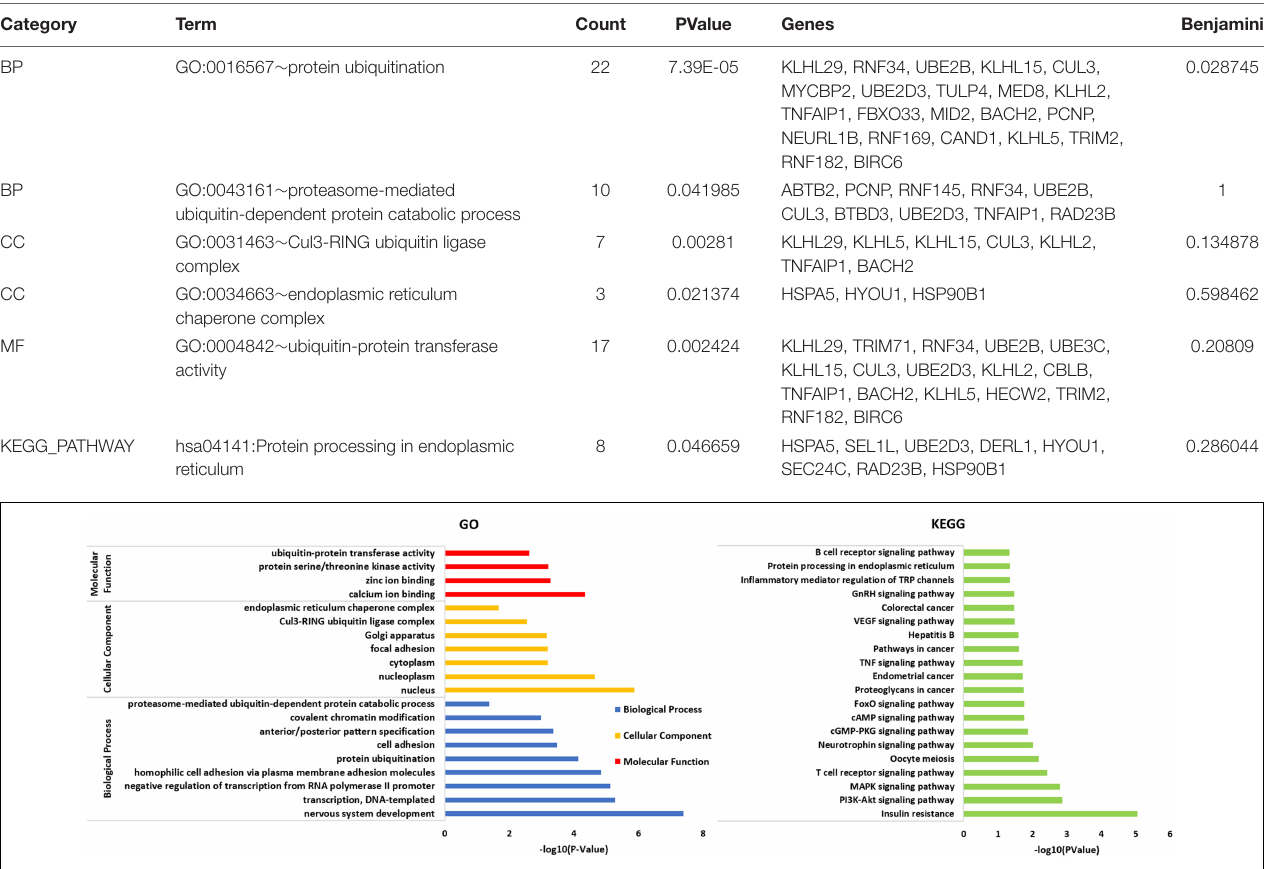
FIGURE 4 | All 402 target genes analyzed by DAVID software and the results of GO analysis and KEGG analysis ( P < 0.05) shown in the figure above. The results of GO analysis were classified into three functional groups, including biological process (BP), cellular component (CC) and molecular function (MF). On the basis of GO item classification, the KEGG analysis of the target gene set was mainly enriched in multiple biological pathways ( P < 0.05), for example, MAPK signaling pathway, cAMP signaling pathway, TNF signaling pathway and the specific molecular pathway of the endoplasmic reticulum chaperone complex involved in the ubiquitin-dependent protein catabolic